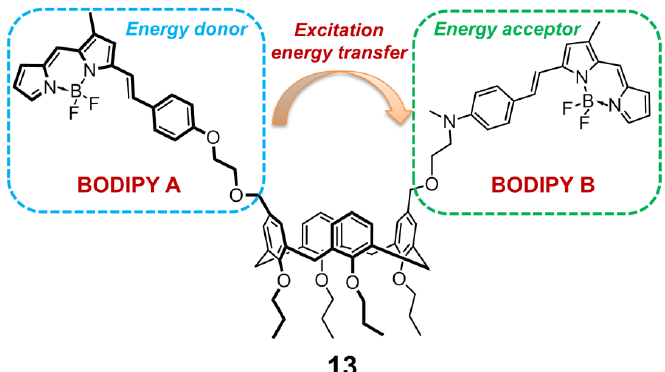
Figure 12. Chemical structure of calix[4]arene derivative 13 decorated with two di ff erent BODIPY chromophores.